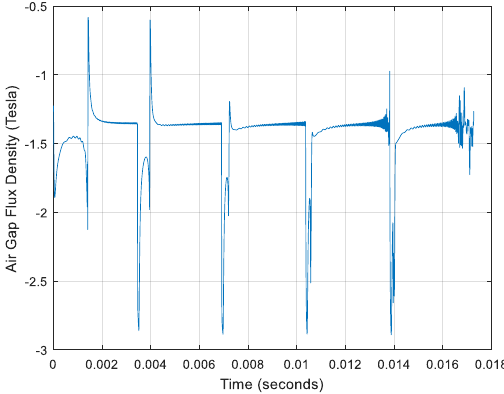
Figure 6. Air gap flux density in time domain (machine with turn-to-turn short circuit fault).